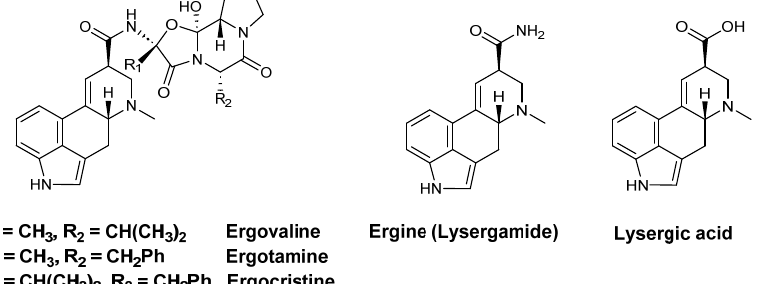
Figure 1. Chemical structures of the alkaloids associated with the wild-type endophytes ( Epichloe coenophiala ) (modified from Schiff [31]).